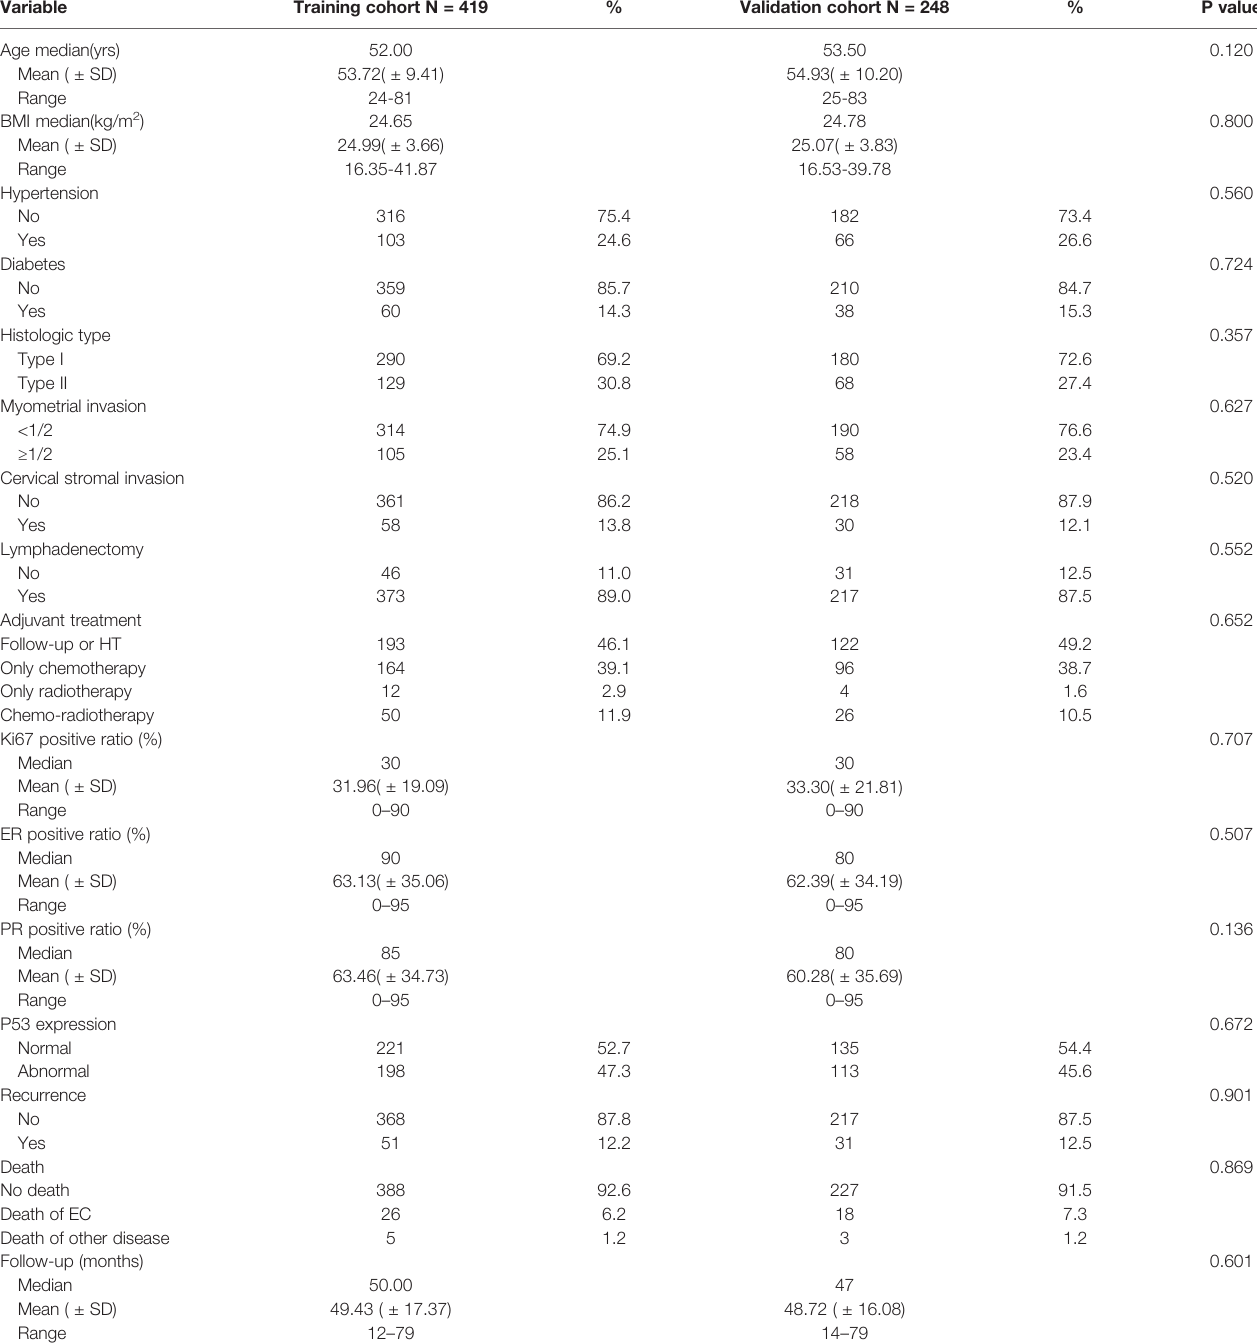
TABLE 1 | Baseline characteristics of the training cohort and the validation